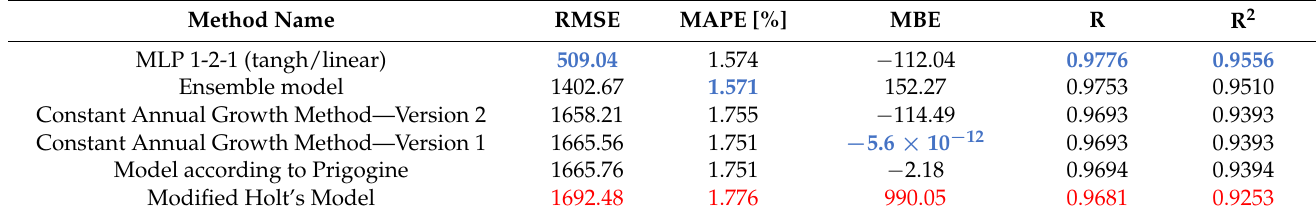
Table 3. Performance metrics for the forecast values of annual power demand in Poland within the model’s parameter estimation range.